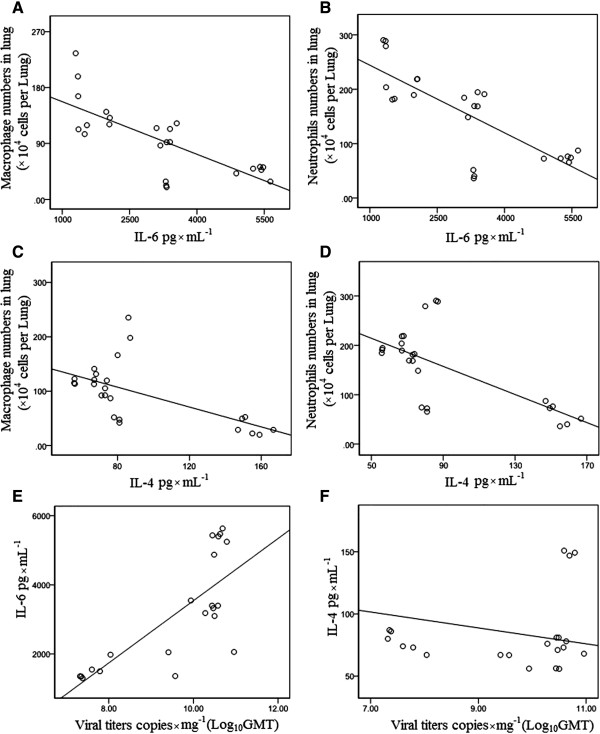
Scatter plot of Table3. (A) Scatter plot of macrophage numbers × 104 per lung and pulmonary IL-6 pg × mL−1 of mice infected with A/PR/8/34 (H1N1) influenza viruses; (B) Scatter plot of neutrophils numbers × 104 per lung and pulmonary IL-6 pg × mL−1 of mice infected with A/PR/8/34 (H1N1) influenza viruses; (C) Scatter plot of macrophage numbers × 104 per lung and IL-4 pg × mL−1 of mice infected with A/PR/8/34 (H1N1) influenza viruses (D) Scatter plot of neutrophils numbers × 104 per lung and pulmonary IL-4 pg × mL−1 of mice infected with A/PR/8/34 (H1N1) influenza viruses; (E) Scatter plot of pulmonary IL-6 pg × mL−1 and viral copies × mg−1(Log10GMT) of mice infected with A/PR/8/34 (H1N1) influenza viruses; (F) Scatter plot of pulmonary IL-4 pg × mL−1 and viral copies × mg−1(Log10GMT) of mice infected with A/PR/8/34 (H1N1) influenza viruses.